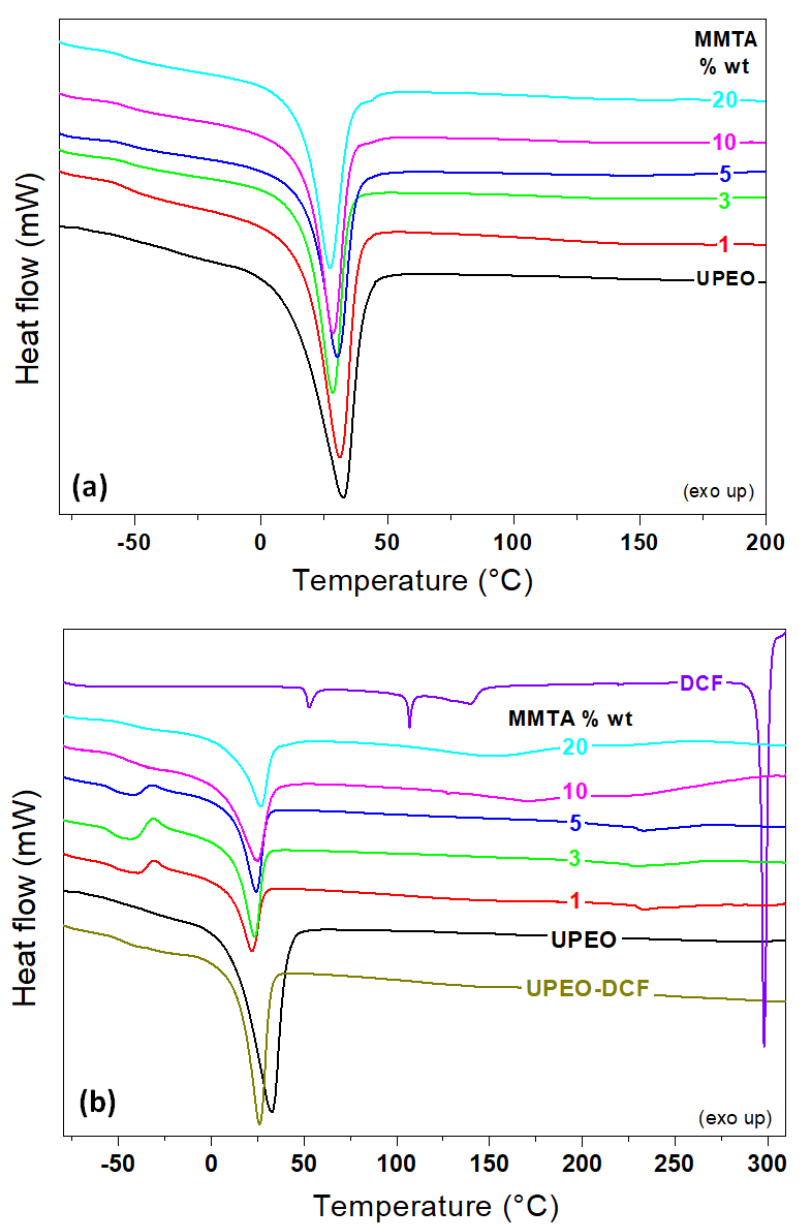
Figure 3. DSC of ( a ) UPEO containing amounts of MMTA variables from 1 to 20% wt and ( b ) DCF,